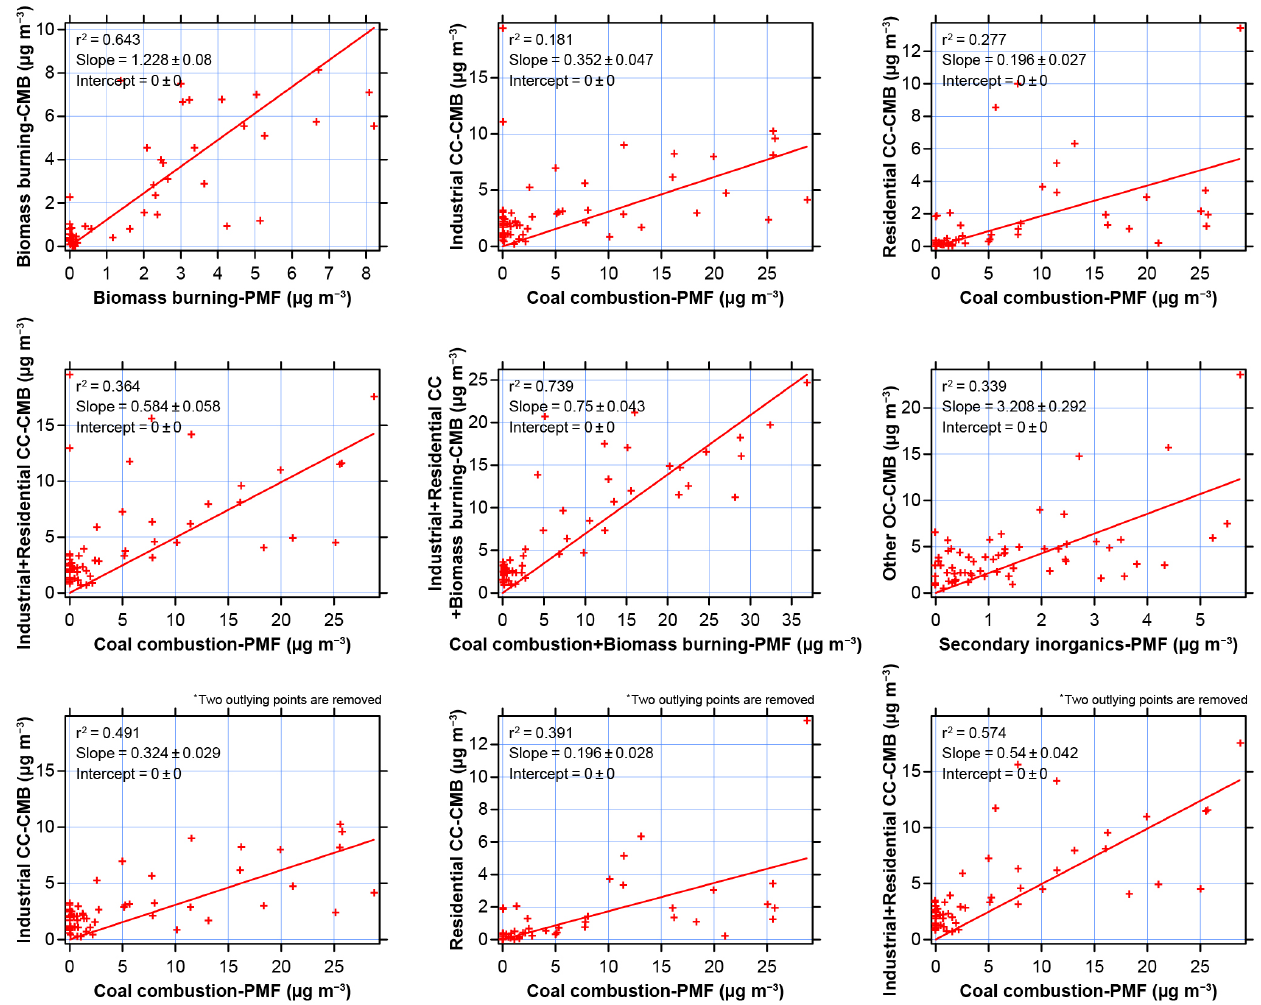
Figure 4. Correlations observed between PMF and CMB results at IAP. ∗ If two outlying points are removed from the coal combustion-PMF, correlations are markedly